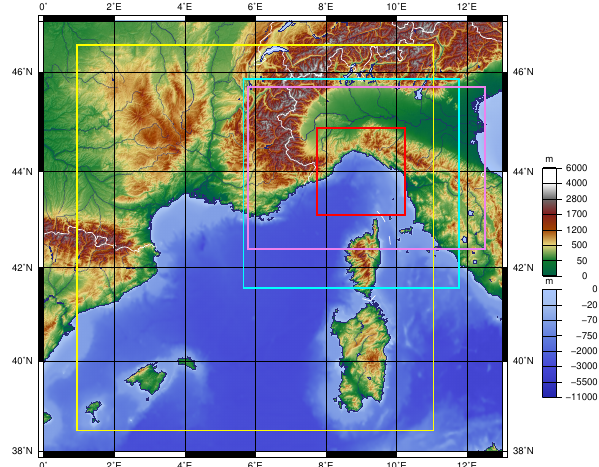
Figure 4. Map showing the location of the interested zone. The innermost domains of the simulations for the different models are WRF-NMM (pink), WRF-ARW (blue), Meso-NH (red) and AROME